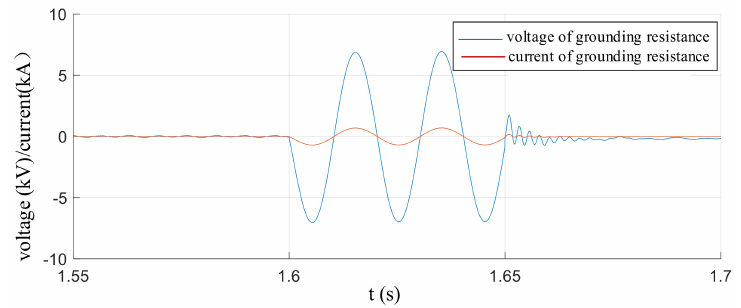
Figure 13. Voltage and current waveform of grounding resistance.